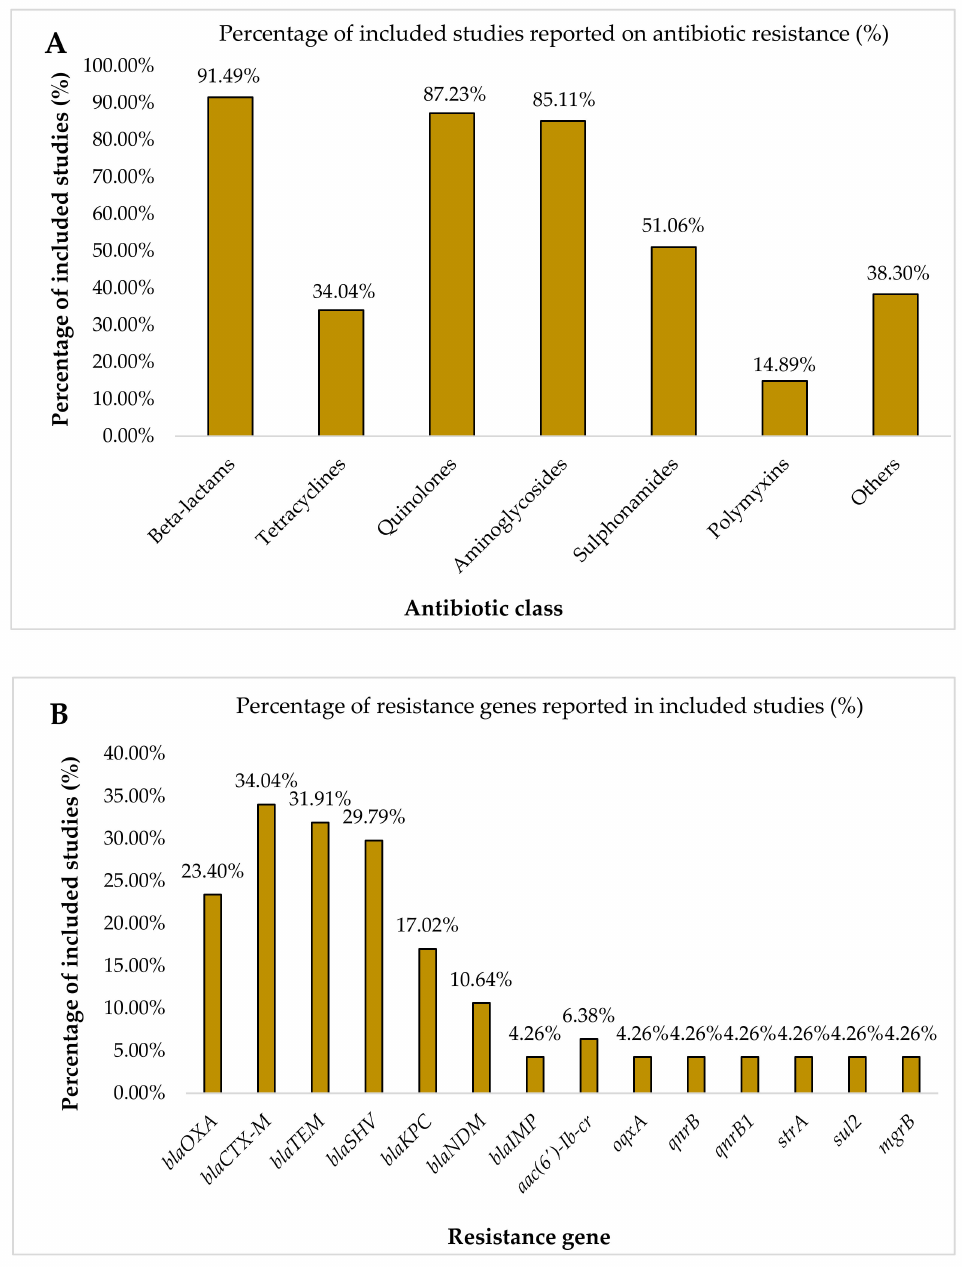
Figure 2. Percentage of resistance according to ( A ) antibiotic classes and ( B ) resistance genes in the included